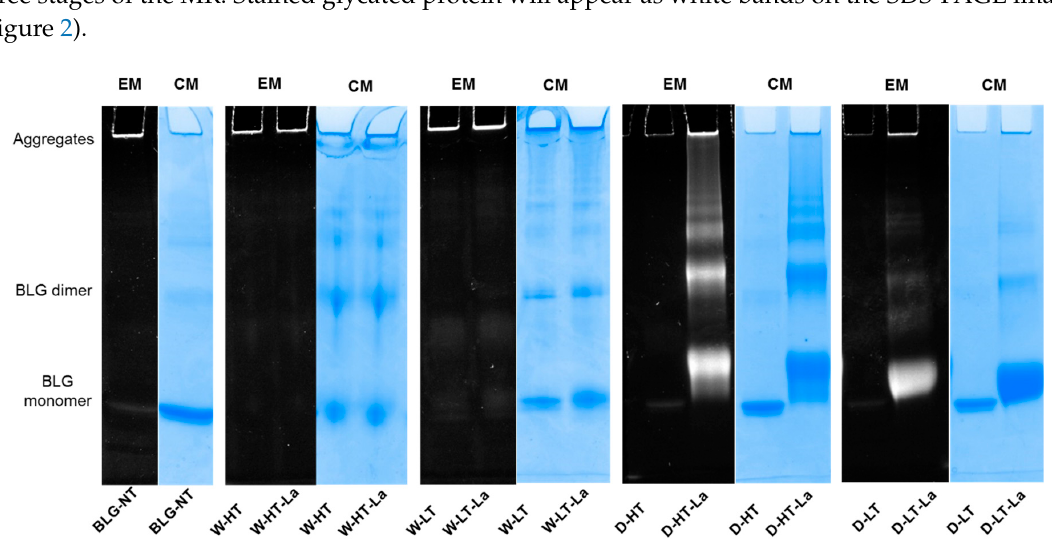
Figure 2. Non-reducing SDS-PAGE image of soluble BLG heated and glycated in a wet system (W) and in a dry system (D), respectively in the absence of lactose or in the presence of lactose (La) and at either high temperatures (HT) or low temperatures (LT). Gels were stained with Q TM Emerald 300 staining for glycoproteins (EM) and Coomassie staining (CM) for total protein staining.